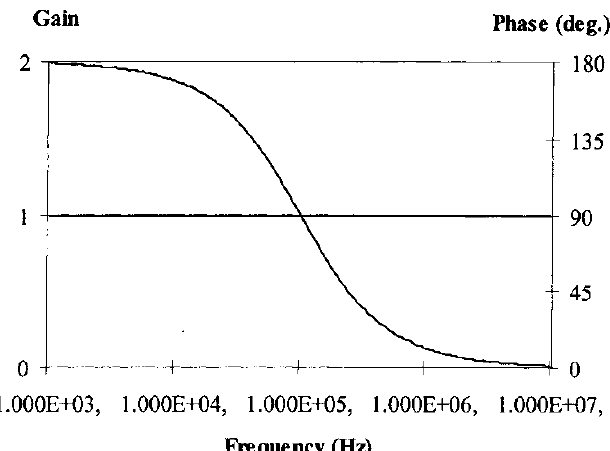
FIGURE 6 Simulated frequency response for APS-II.